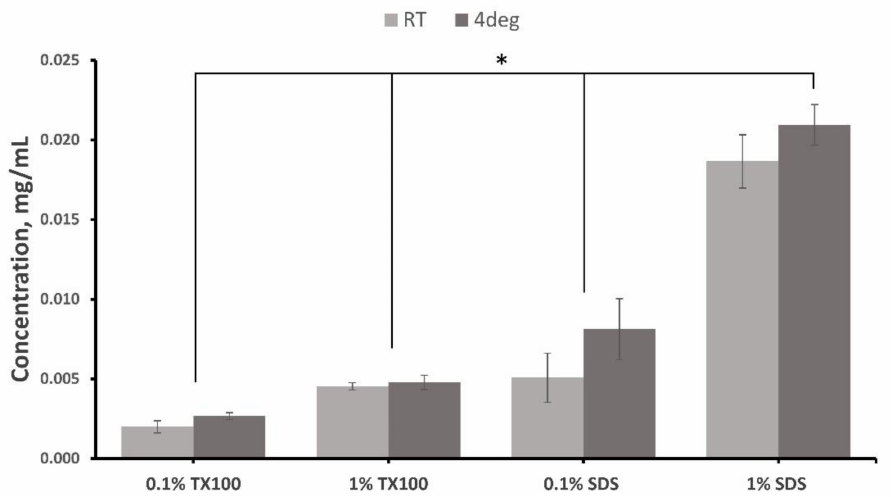
Figure 7. Residual detergent test for Triton X-100 and SDS in the decellularized extracellular matrix of milkfish skin. Bars represent standard deviation ( n = 3). * p <